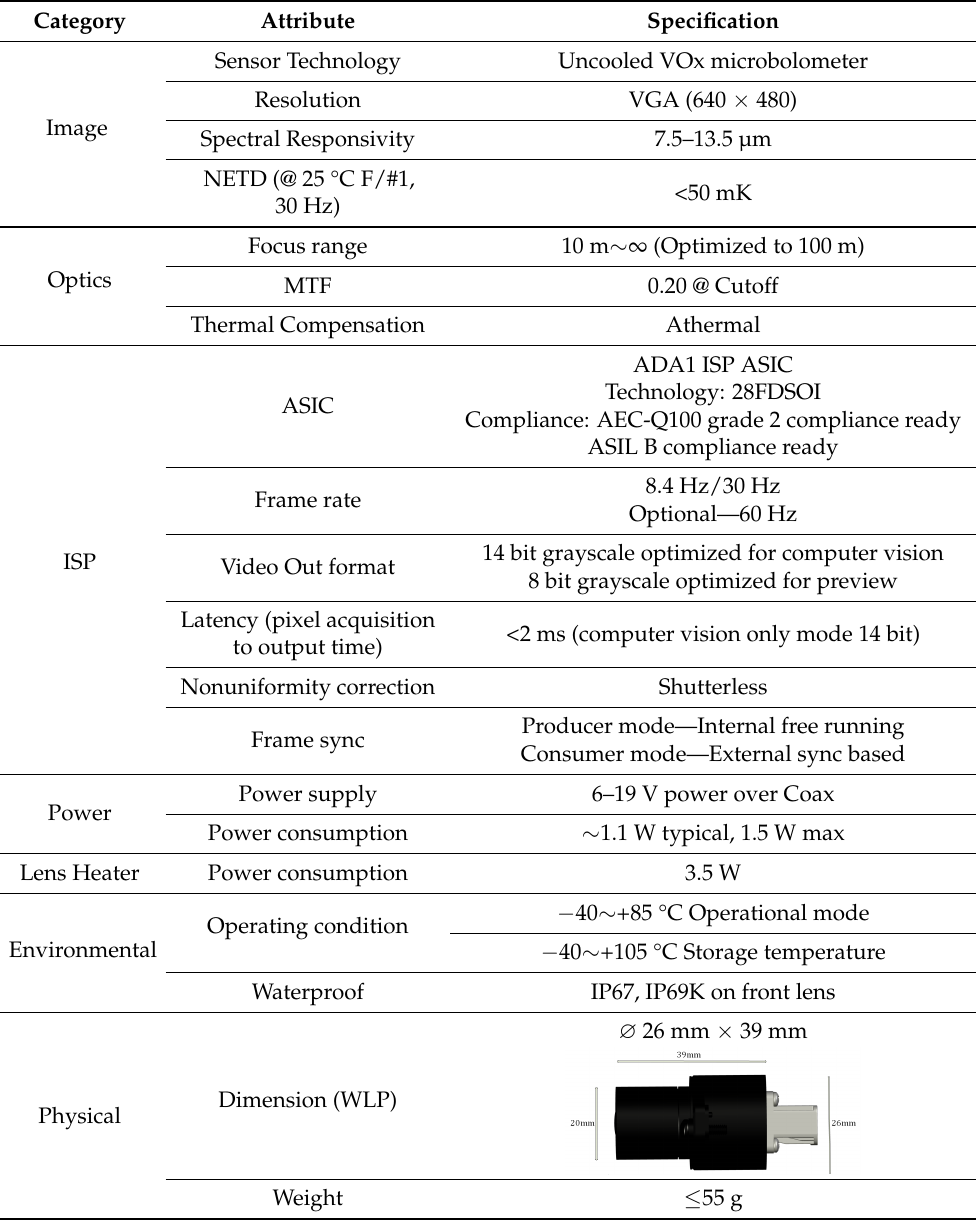
Table 1. The ADASKY camera’s key technical